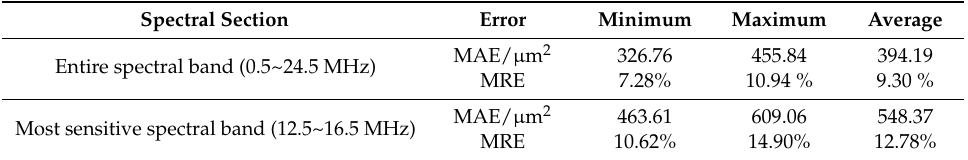
Figure 7. Error distribution of all tested samples of 10 retrainings using the most sensitive spectral band (12.5–16.5 MHz) and the entire spectral band (0.5–24.5 MHz). ( a ) Absolute error distribution for all tested samples. Absolute errors are mainly within the range of 0 to 500 µm 2 when training on the entire spectral band. The distribution of the relative errors is shown in ( b ). Table 3. Mean absolute errors (MAEs) and MREs of the test set in 10 retrainings using the most sensitive spectral band and entire band.